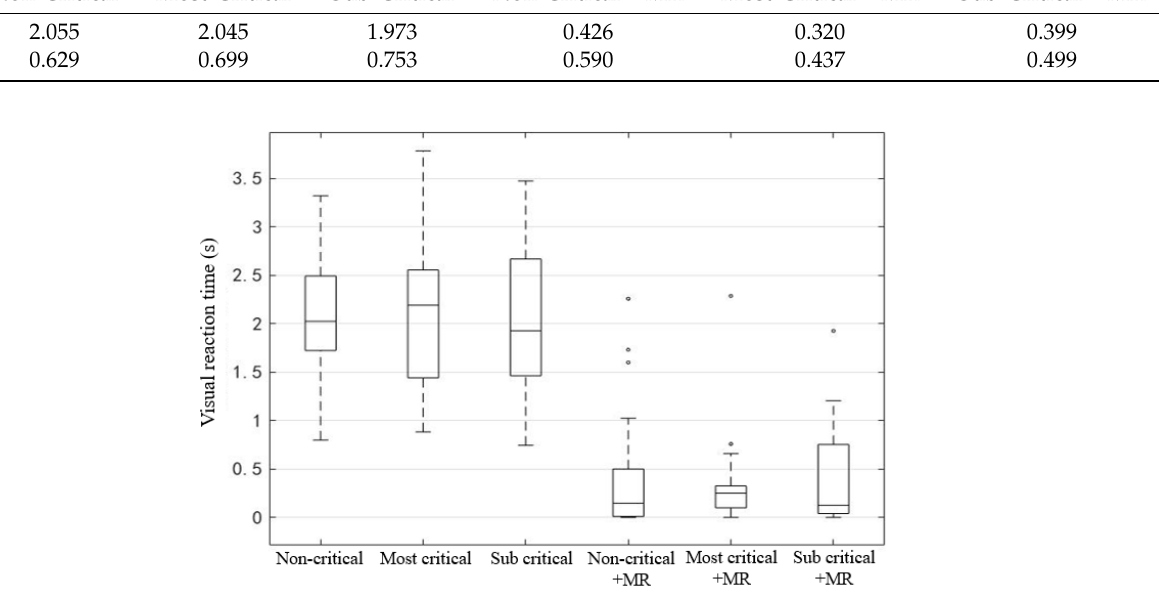
( f ) Figure 8. Thermal distribution of viewpoint: ( a ) non-critical; ( b ) most-critical; ( c ) sub-critical; ( d ) non-critical with MR; ( e ) most-critical with MR; ( f ) sub-critical with MR. It was found that the total fixation duration of the front road area increased in all scenarios with MR compared to those without MR. This meant that since participants had fully observed the surrounding driving conditions during the pre-alert period, they could more calmly allocate more time to the road ahead after taking over, rather than observing everywhere aimlessly and in a panic (Table 5). Because they were more leisurely, partici- pants in the scenarios with MR looked at the road ahead more often than those in the scenarios without MR, and because of the increase of points, the average single fixation time in some scenarios with MR decreased slightly (Figure 9).